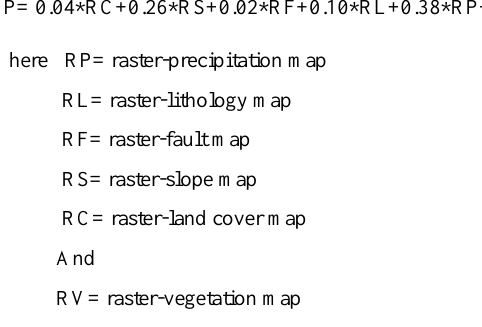
Figure 8. The final map of ground water potential